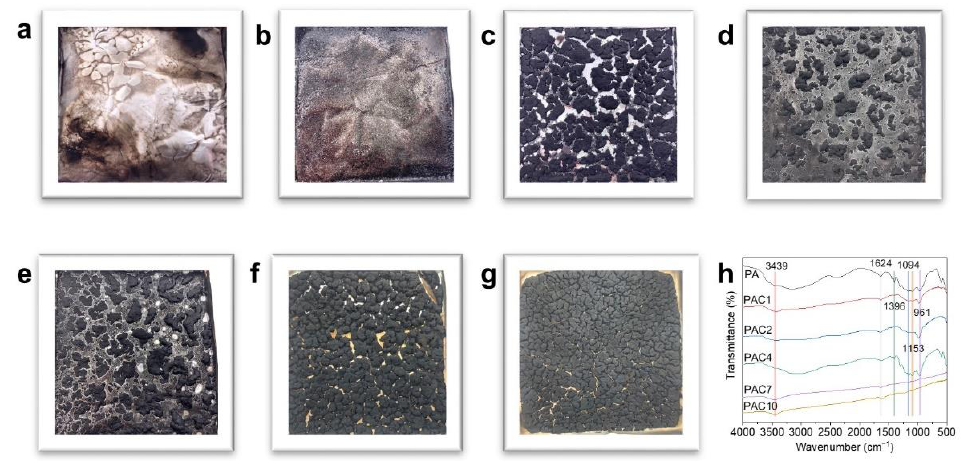
Figure 7. Digital photographs of ( a ) PS, ( b ) PA, ( c ) PAC1, ( d ) PAC2, ( e ) PAC4, ( f ) PAC7, and ( g ) PAC10 after CCT and ( h ) FTIR spectra of the char residues of PS composites.